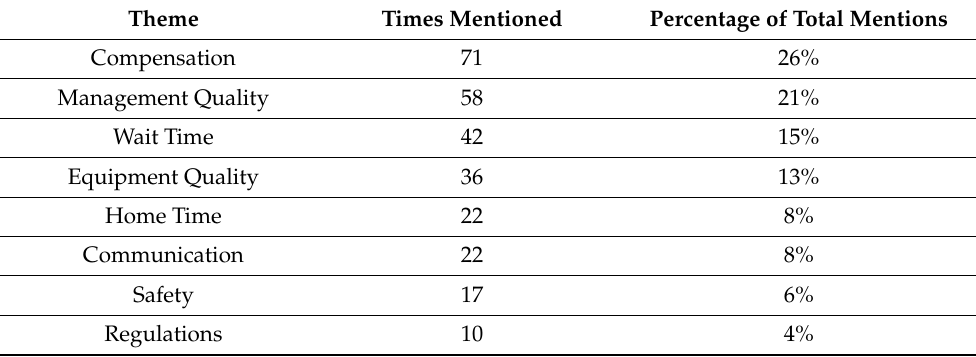
Table 2. Number of Mentions by